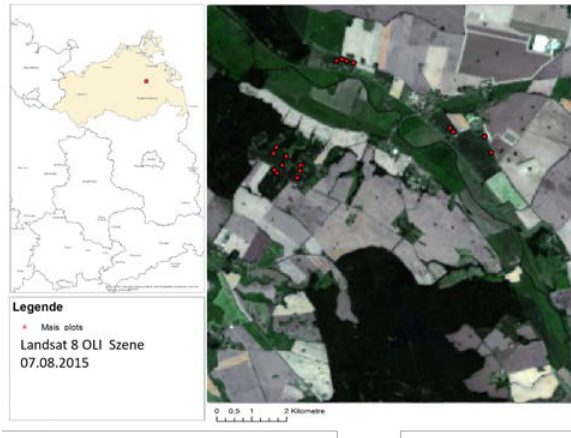
Figure 1: Study site and location of ESUs on maize fields The investigated fields were within the test site DEMMIN (Durable Environ-mental Multidisciplinary Monitoring In- formation Network), one of four test areas of the TERENO NE Lowland observatory (http://demminweb.dlr.de/). The test site is an intensively used agricultural ecosystem dominated by extensive fields (80 ha) where mainly wheat and maize are cultivated. The northern part of the study area is characterized by low topographical variations between 5 - 84.5 m a.s.l.. The south can be described as hilly to undulating. Due to significant differences in parent substrate material and topography, soils are primarily loamy sands and sandy loams alternating with pure sand patches or clayey areas (Gerighausen et al. 2007).